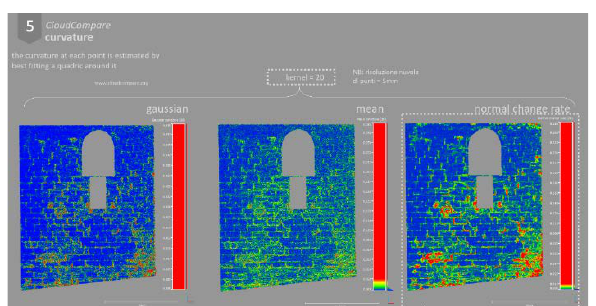
Figure 13. Comparison between the curvature maps with same kernel.